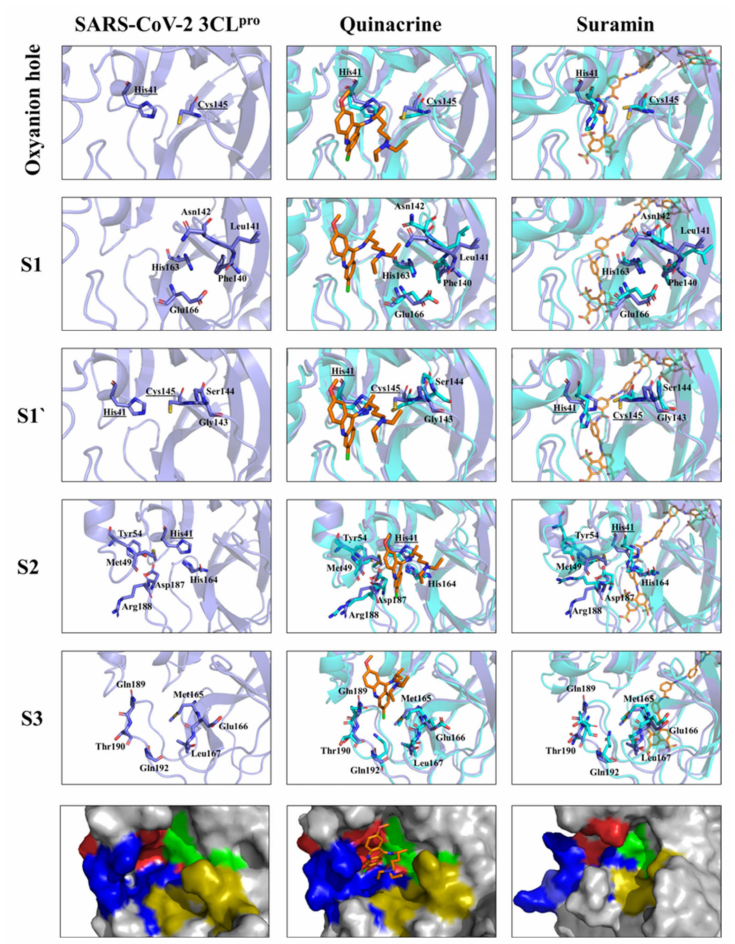
Figure 6. Substrate-binding pocket and oxyanion hole of SARS-CoV-2 3CL pro (S1, S1’, S2, and S3) free accessibility and under quinacrine and suramin influence. The structural overlay between the single protein and in complex, the active site residues are highlighted. The amino acid residues are shown in sticks. The surface view (zoom) of the substrate-binding area demonstrates the occupied area by the molecules and the conformational changes induced by its binding. Substrate-binding subsites highlighted in green for S1’, gold for S1, red for S2, and blue for